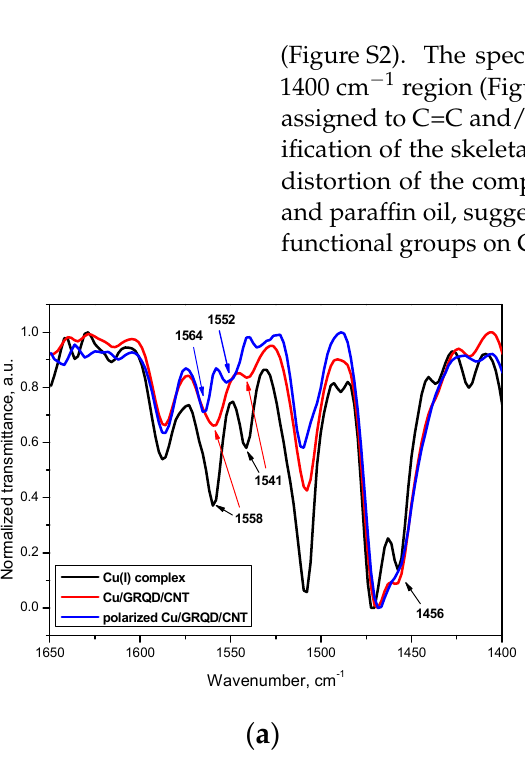
Figure 2. ( a ) 1650–1400 region of FT-IR spectra of Cu(I)_BF 4 , paste electrode Cu/GRQD/ CNT and polarized Cu/GRQD/ CNT; ( b ) 1650–1400 region of FT-IR spectra of complex Cu(I), thermally ordered complex Cu(I) and paste electrode Cu/GRQD/CNT.